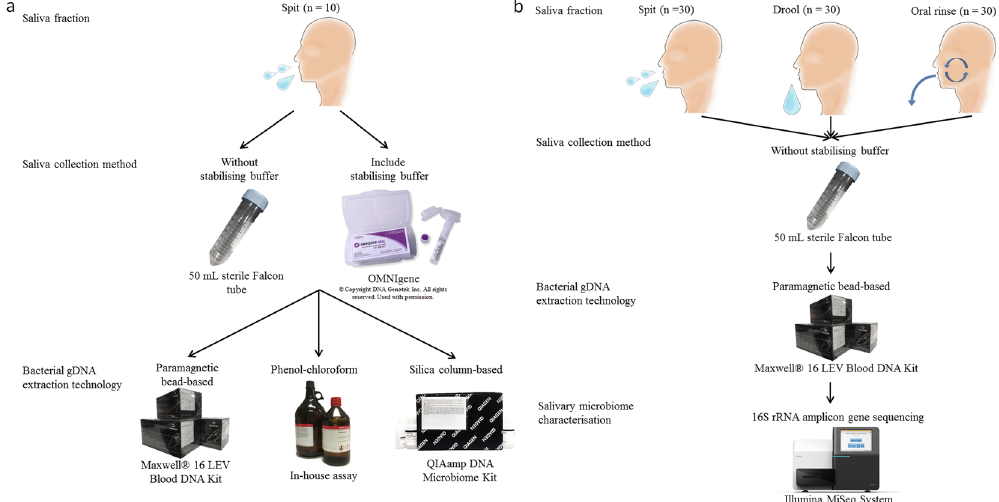
Figure 1. Study design overview. From Fig. 1a, Maxwell ® 16 LEV Blood Kit was found to be the most efficient bacterial gDNA extraction method when spit samples were collected in 50 mL sterile Falcon tube.